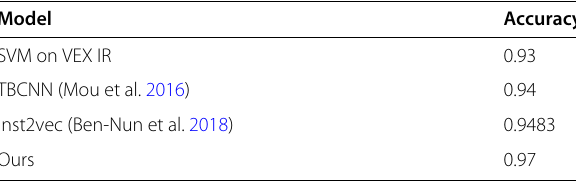
Table 3 Accuracy obtained for the first task on the online judge problem